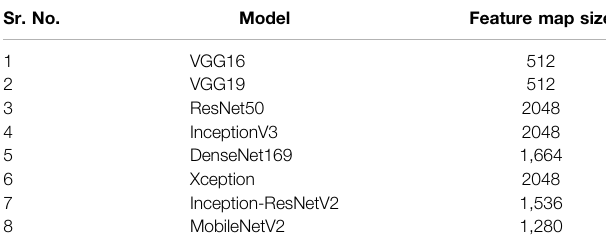
TABLE 5 | Feature map sizes in pre-trained deep learning models. Sr.